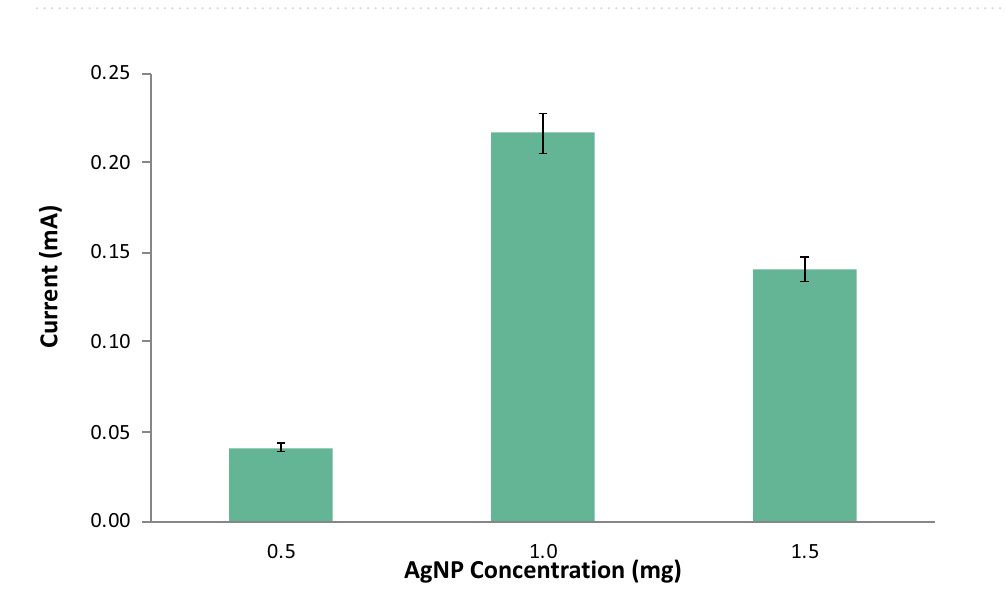
Figure 5. Anodic current peaks for varying amounts of AgNP.